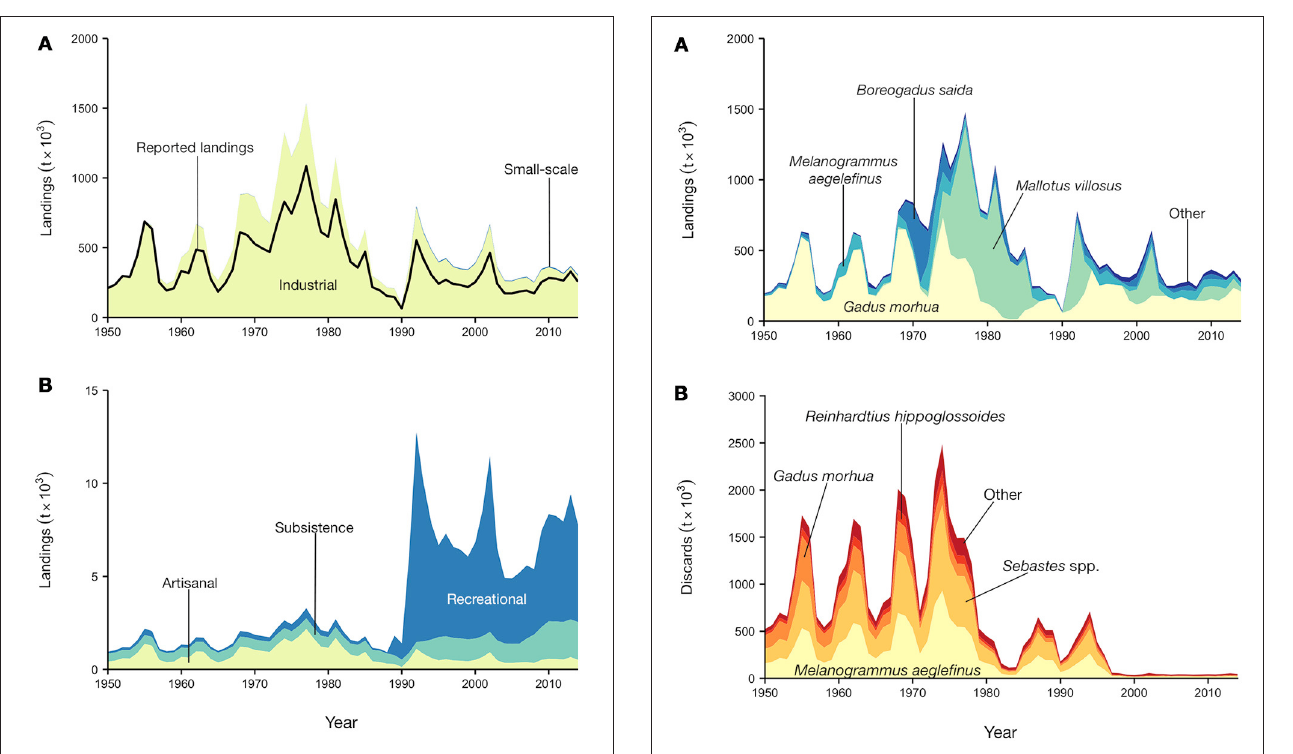
FIGURE 3 | Taxonomic composition of Russian Barents Sea fisheries catches with (A) total landings by the four major landed taxa and all other taxa pooled ( n = 59); and (B) total discards by the four major discarded taxa and all other taxa pooled ( n =